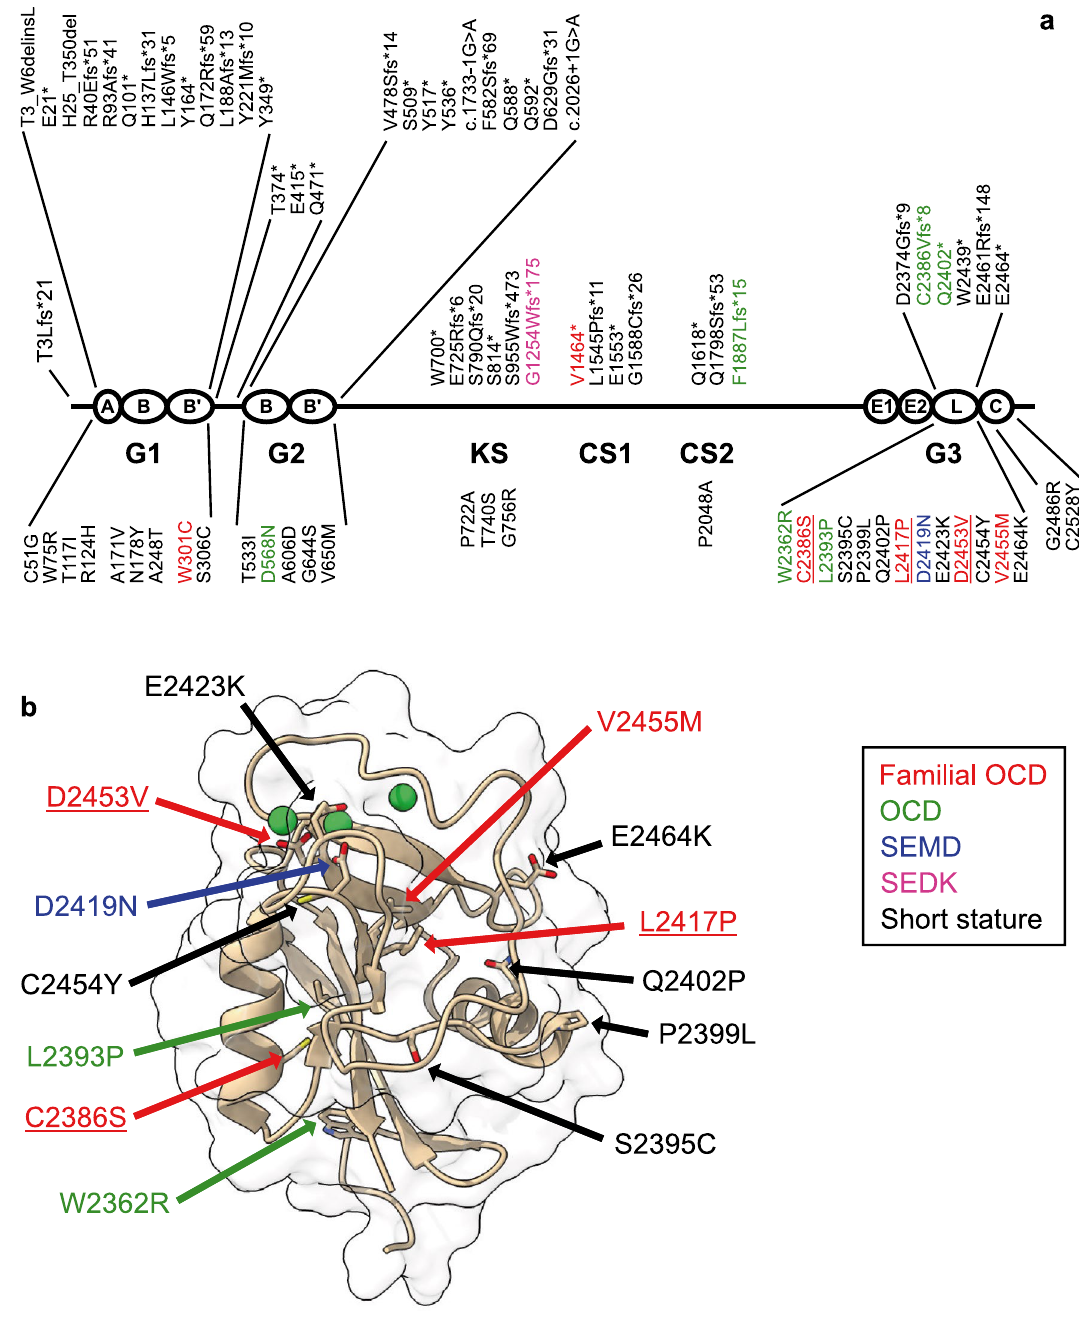
Figure 4. Hereditary ACAN variants segregating with skeletal disorders. ( a ) ACAN variants (published until October 2021) are shown schematically on the domain structure of the aggrecan core protein. Missense variants are shown below the core protein, all other types of variants above. Variants linked to familial OCD are shown in red, SEMD in blue and SEDK in pink. Variants where OCD has been reported in only one family member are shown in green. The novel fOCD variants reported in this study are underlined. ( b ) Locations of amino acid residues mutated in missense ACAN variants shown on the structure of the G3 domain C-type lectin repeat. Green spheres represent coordinated calcium ions. ACAN variant colouring is the same as in ( a